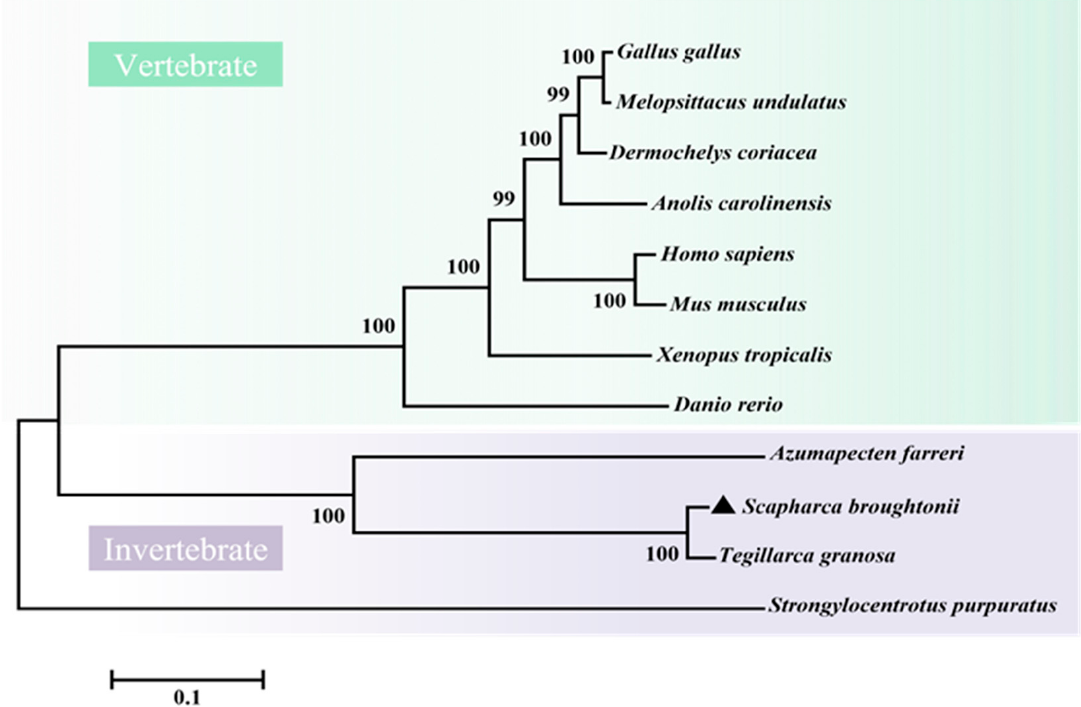
Figure 4. Phylogenetic tree of IGF-1Rs across species. The tree was obtained using the neighbor- joining method of MEGA 6.0. The percentage at the forks indicates the bootstrap value for 1000 replications. The black triangle indicates Sb IGF-1R. The accession numbers of these proteins obtained from GenBank are listed below: Homo sapiens IGF-1R (BAG11657.2), Mus musculus IGF-1R